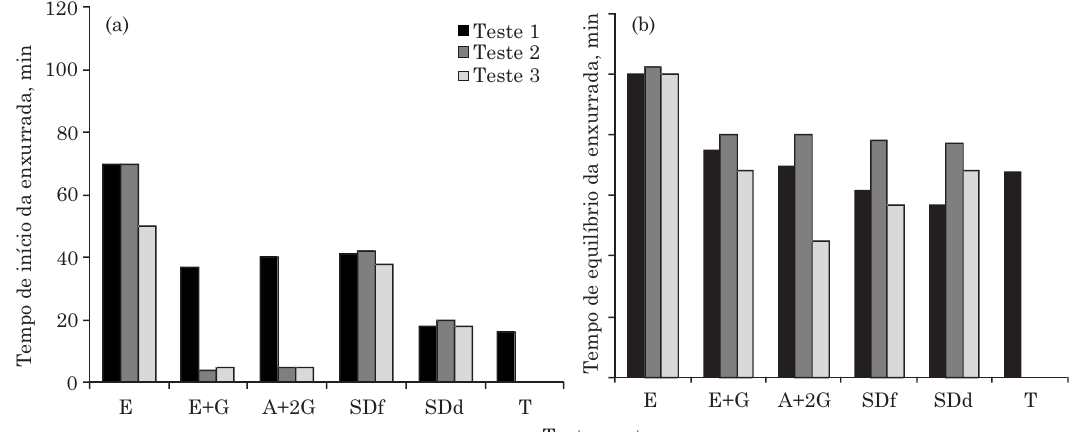
Figura 2. Tempos de início (a) e de equilíbrio (b) da enxurrada, medidos em cada teste de erosão (Teste 1, Teste 2 e Teste 3) com chuva simulada, nos tratamentos